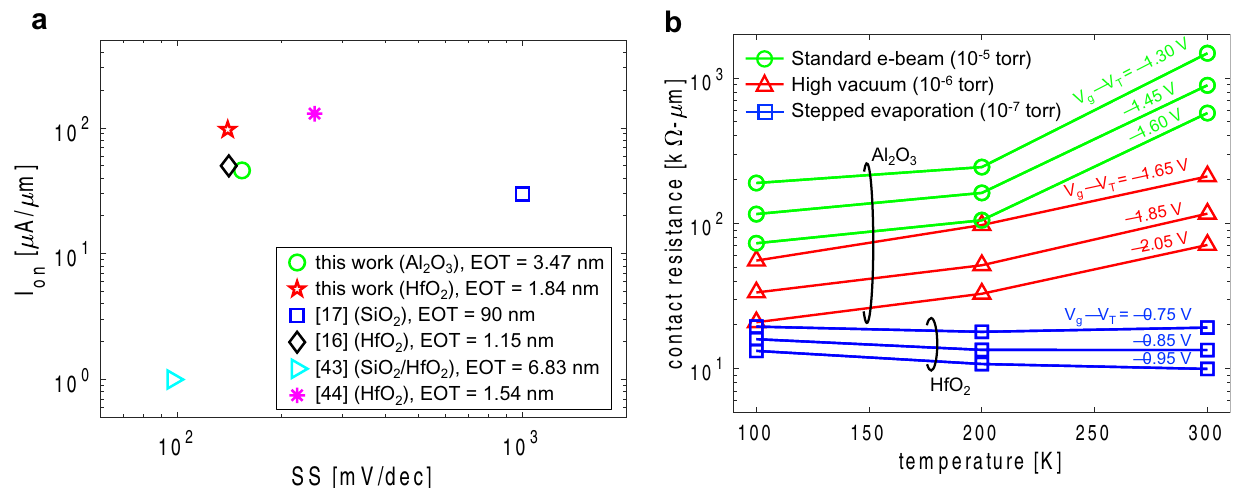
Figure 5. ( a ) 2D PMOS FET performance benchmark of on-state current (I on ) versus subthreshold swing (SS). This plot includes our results from WSe 2 devices prepared with high-vacuum evaporation and stepped metal contact deposition (low contact resistivity of ~ 6 kΩ-µm) with two different high-K dielectrics (Al 2 O 3 and HfO 2 ). Also shown are previous results with record contact resistivities. Our devices show improvements indicated by higher I on while maintaining low SS (see text). ( b ) Contact Resistance as a function of temperature from three devices prepared with different metal evaporation techniques. For each case three curves are shown corresponding to three different V g (i.e., different sheet carrier density). Moving from standard e-beam evaporation (10 –5 torr), to mid-level vacuum (10 –6 torr), and higher vacuum (10 –7 torr) plus stepped evaporation we see a reduction in contact resistance and a transition in the temperature dependence (see